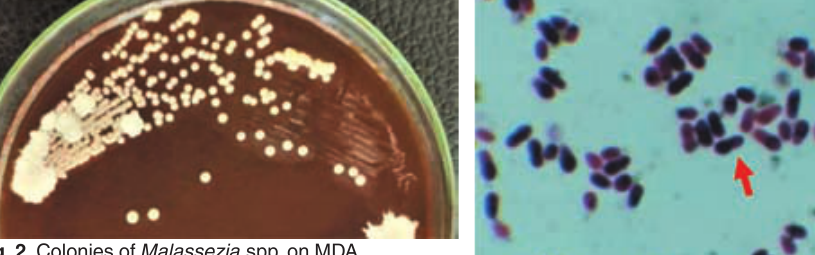
Fig. 2. Colonies of Malassezia spp. on MDA